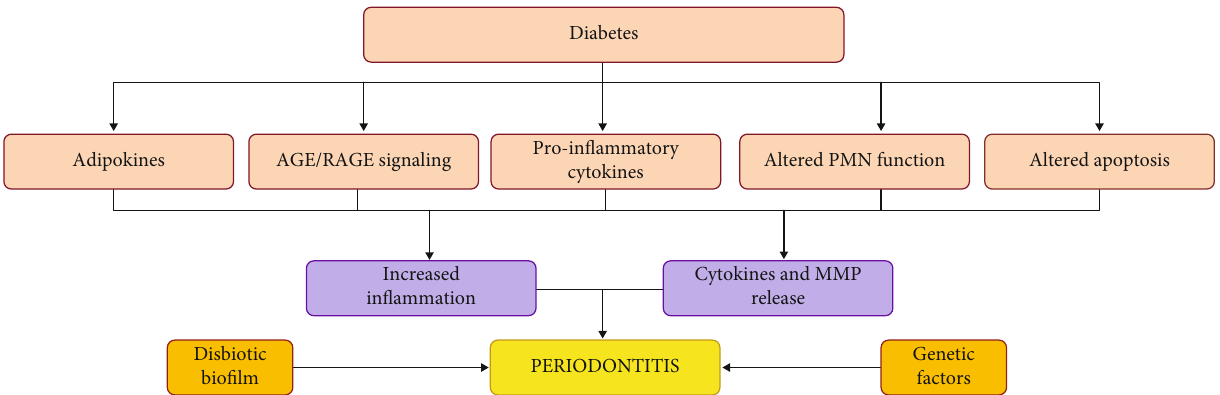
Figure 1: Impact of diabetes on periodontal health. Hyperglycemia in diabetic subjects favors di ff erent pro-in fl ammatory responses that a ff ect the systemic health and the periodontal tissues. The incremented adipokine production (especially in obese adults) induces the release of di ff erent pro-in fl ammatory mediators such as leptin, IL-6, and TNF- α . Furthermore, AGEs deposition in the di ff erent human tissues further stimulates cytokine release and in fl ammation. Another mechanism of periodontal tissue destruction is the altered neutrophil polymorphonucleates ’ (PMN) function characterized by enhanced respiratory burst and delayed apoptosis. MMP is the acronym of metalloproteinases. All these factors combined to genetic predisposition and pathological subgingival bio fi lm lead to the increased risk of severe periodontitis